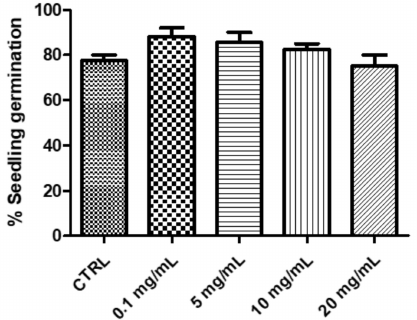
Figure 4. Null effect induced by P. mahaleb L. water extract (0.1–20 mg/mL) on the seedling germina- tion of the lettuce variety Lollo bionda.